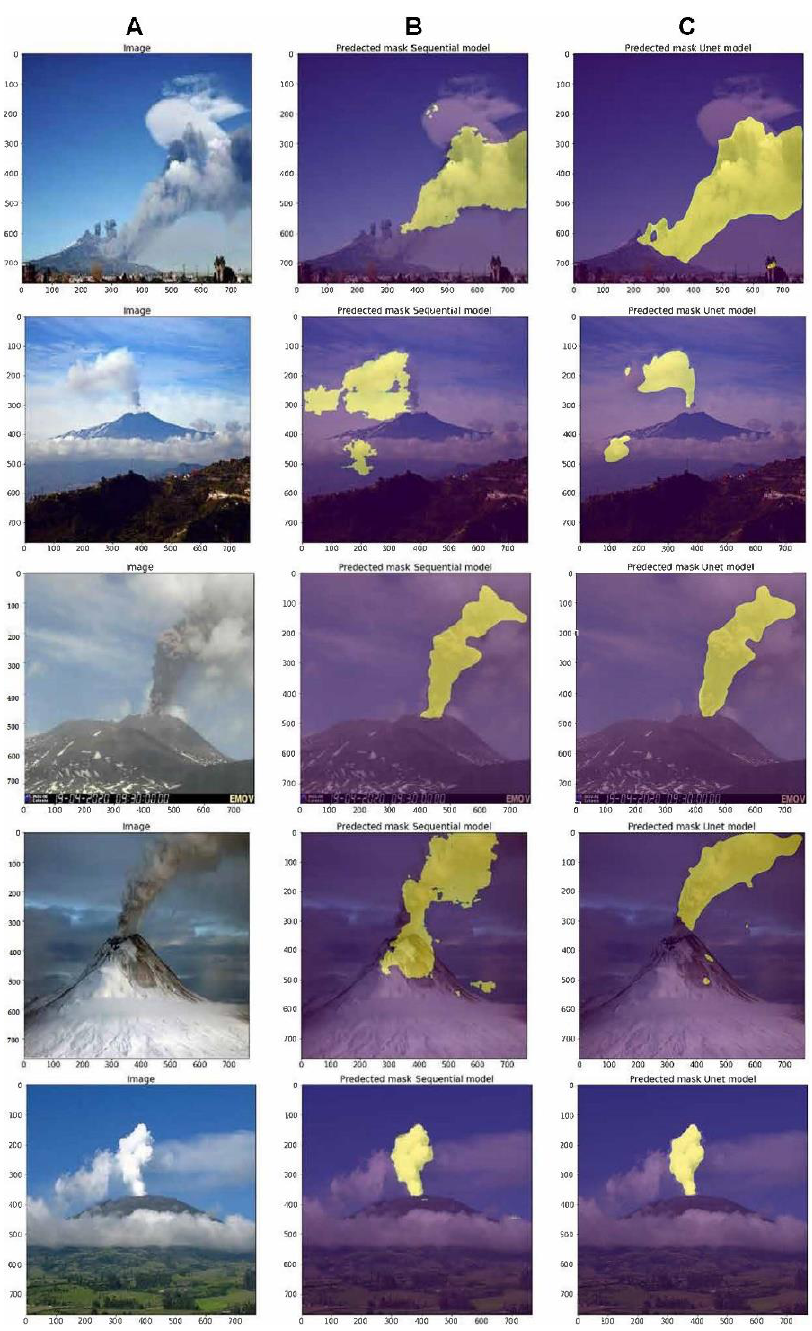
Figure 14. Semantic segmentation of results from test dataset: original image ( A ), predicted mask by SegNet (B), predicted mask by U-net ( C ).